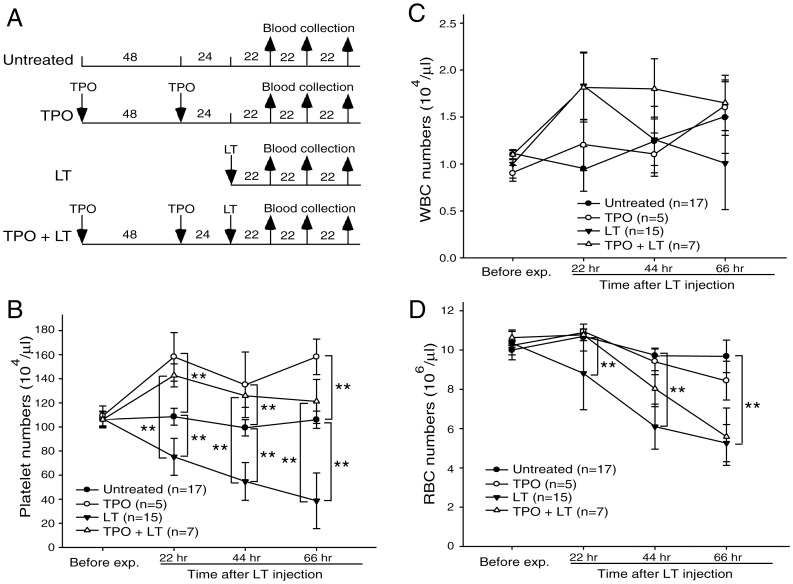
TPO pretreatments ameliorated LT-mediated thrombocytopenia in mice.(A) The experiment outline used in measurement of hematopoietic parameters. (B–D) The platelet, WBC, and RBC counts of mice treated with TPO, LT, or TPO plus LT at 22, 44, and 66 hours, respectively. The measurements of platelet, WBC, and RBC counts right before TPO and/or LT treatments [prior to first TPO treatments of TPO groups in (A)] were served as basal levels (Before exp. groups, C–D). Untreated mice were used as negative controls. **p<0.01 compared between indicated groups. Data are reported as mean ± standard deviation (SD) and representative of 2 independent experiments.